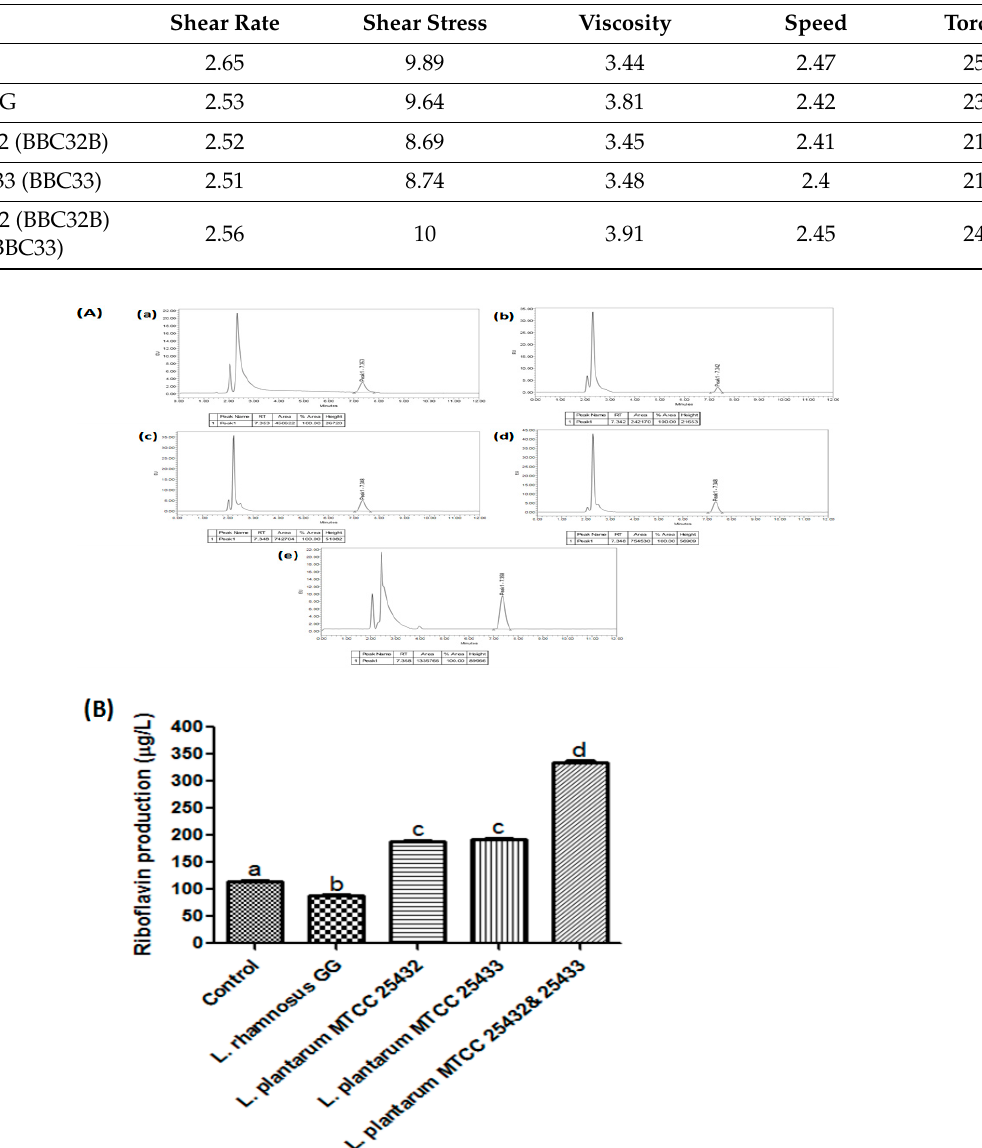
Figure 3. Riboflavin estimation; ( A ), Chromatograms obtained after HPLC analysis of the unfermented soymilk (a) and the soymilk fermented with L. rhamnosus GG (b), L. plantarum MTCC 25432 (BBC32B) (c), L. plantarum MTCC 25433 (BBC33) (d), and a combination of L. plantarum MTCC 25432 (BBC32B) and MTCC 25433 (BBC33) (e). ( B ), Significantly highest riboflavin production in the soymilk fermented with a combination of L. plantarum MTCC 25432 (BBC32B) and MTCC 25433 (BBC33) strains in comparison to other strain of L. plantarum MTCC 25432 (BBC32B) and L. plantarum MTCC 25433 (BBC33) in relation of riboflavin level in the soycurd fermented with L. rhamnosus GG and unfermented soymilk. The values are expressed as mean ± SEM of three independent experiments with significant difference ( p < 0.0001) among all the pure